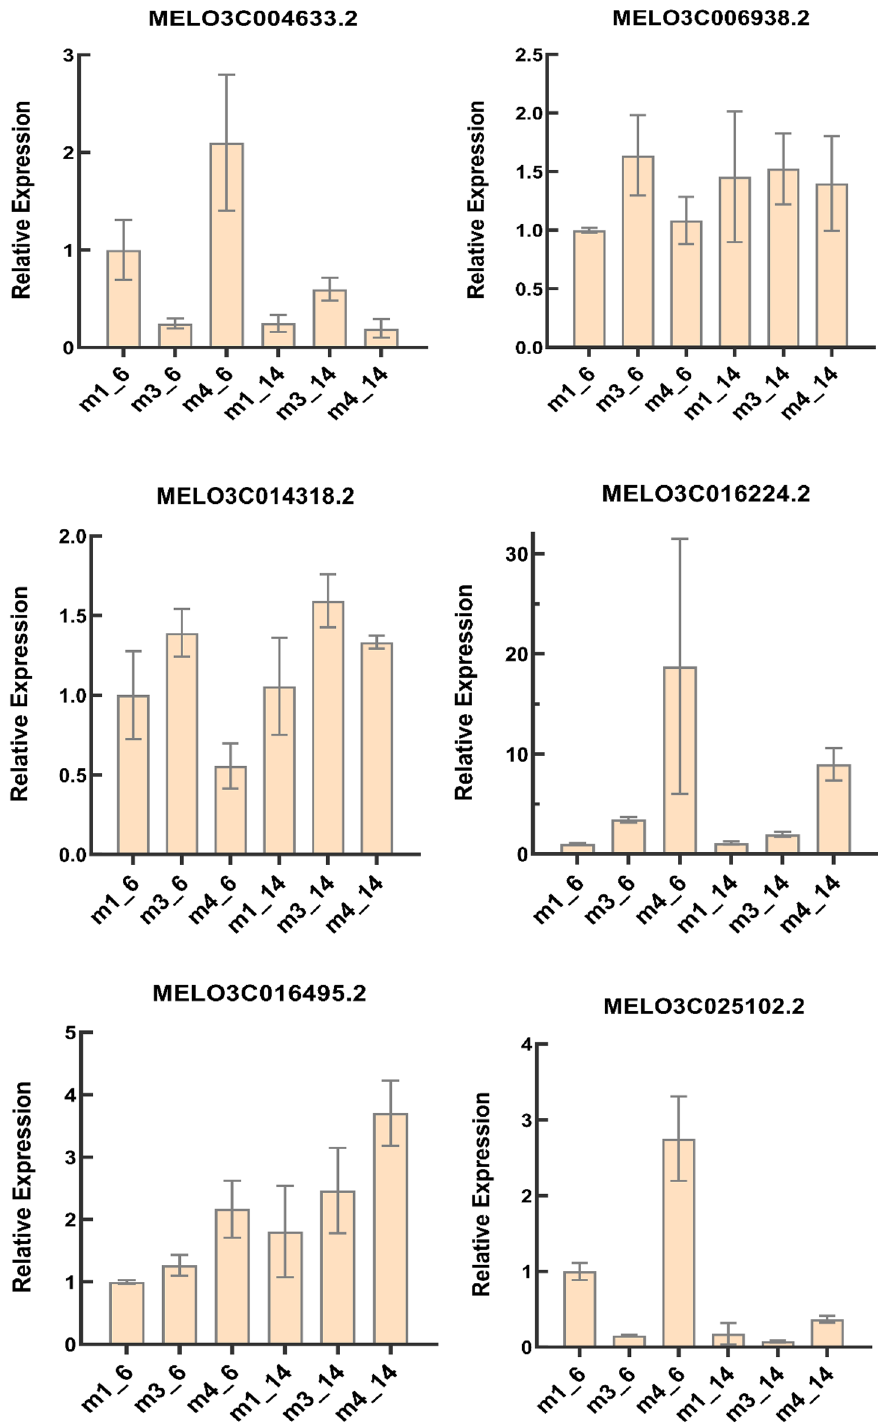
Figure 8. The expression levels of six carotenoid-related genes in flesh of “B-14” and “B-6” melon cultivars at different developmental